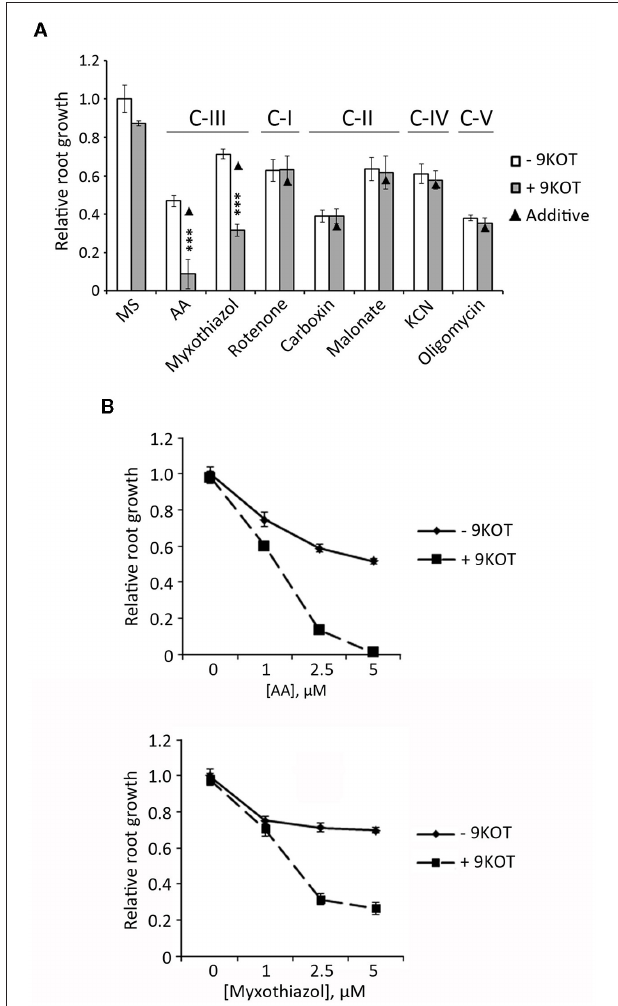
FIGURE 6 | Root growth phenotype in seedlings treated with 9-KOT and inhibitors of respiratory complexes. (A) Root growth (relative to MS) of wild type plants grown for 4 days in MS, and then transferred to MS with 2.5 µ M AA (C-III), 2.5 µ M Myxothiazol (C-III), 50 µ M Rotenone (C-I), 100 µ M Carboxin (C-II), 2mM Malonate (C-II), 100 µ M KCN (C-IV) or 1 µ M Oligomycin A (C-V), alone or in combination with 12.5 µ M 9-KOT. Black triangles represent expected root growths in combined treatments if both effects were additive (no interaction). Asterisks represent a significant interaction between treatments ( n ≥ 8, Two way ANOVA, *** P < 0.001. (B) Effect on root growth of 12.5 µ M 9-KOT in combination with different concentrations of AA and Myxothiazol. Treatments were applied as in (A)